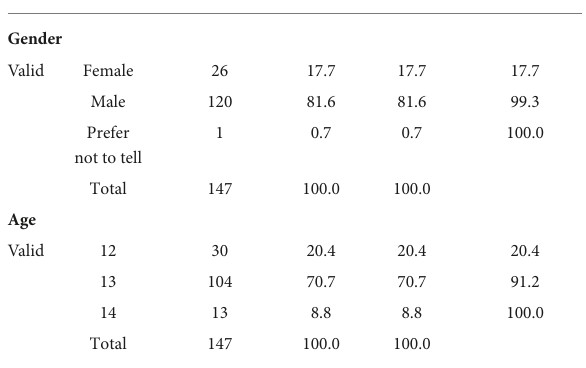
TABLE 1 Demographic